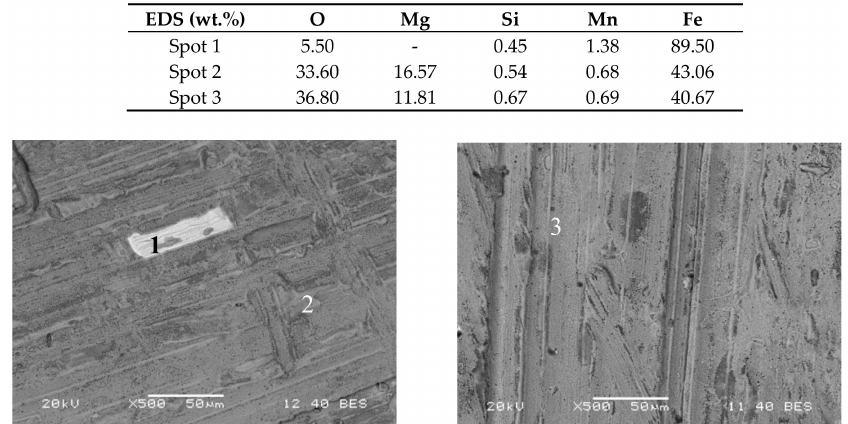
Figure 2. Backscattered surface image CS A516 at 200 h ( Left ) and 600 h ( Right